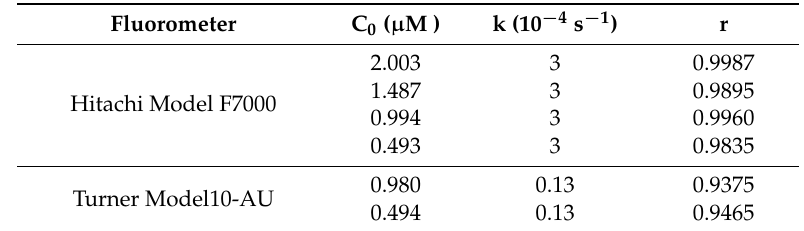
Table 1. The first order reaction rate constants in the photobleaching of scopoletin in the two fluorometers.